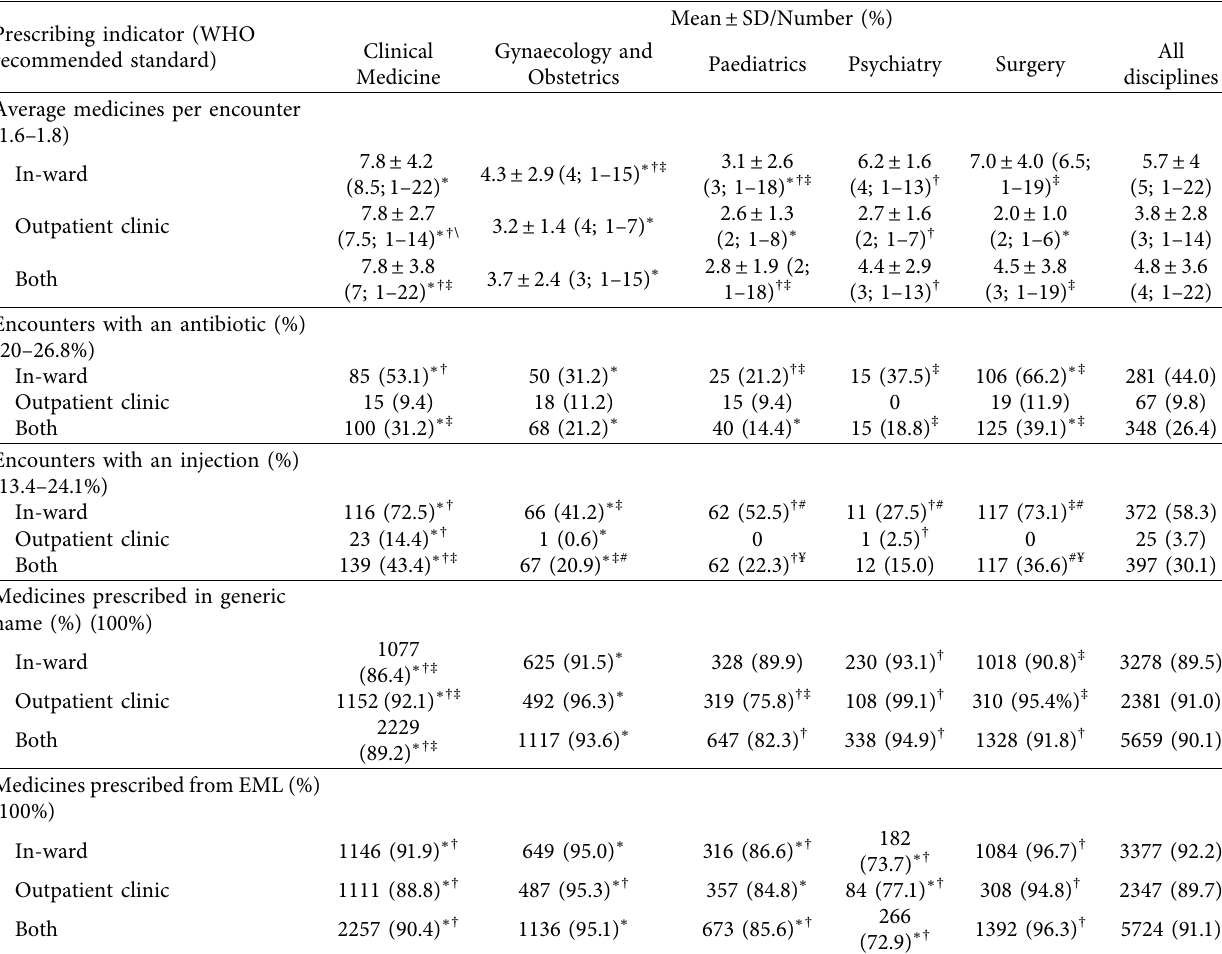
Table 2: In-ward, outpatient clinic, and combined prescribing indicators in the five